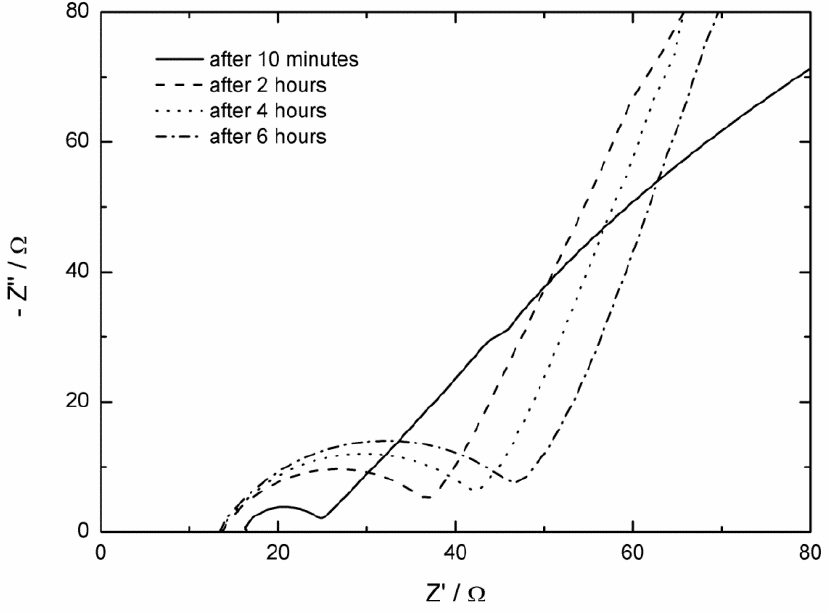
Figure 11. Selection of Nyquist plots of a Li LiDFOB in EC:DEC (3:7, by wt.) as electrolyte of a symmetrical cell of deposited lithium on a copper foil (0.36 As cm − 2 ). The AC impedance measurements were carried out after